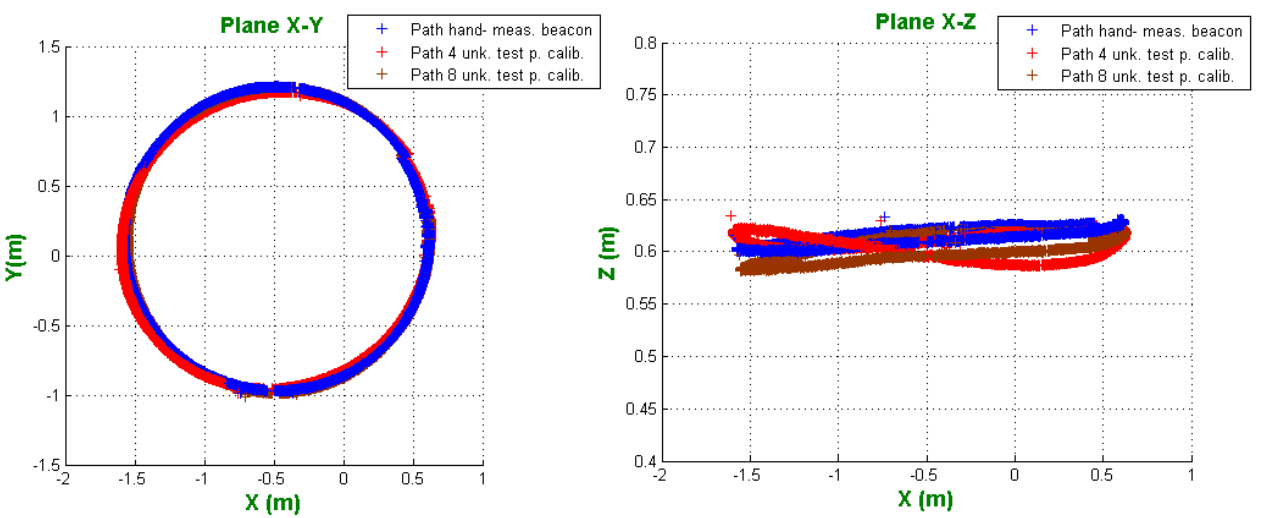
Figure 10. Path obtained using the hand-measured beacon positions and the calibrated beacons (spherical